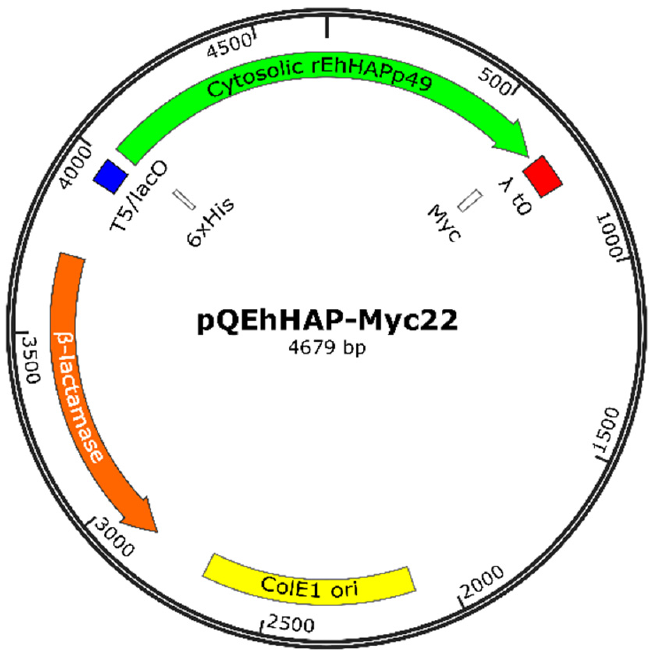
Figure 8. Schematic representation of the pQEhHAP-Myc22 plasmid, which encodes Eh HAPp49 as a 6xHis/Myc-tagged cytosolic protein. ColE1 ori (yellow) functions as the autonomous replication sequence, and the encoded β -lactamase (orange) as a selection marker (Amp R ). As a transcriptional unit, the promoter and terminator: T5/lacO (blue) and λ t0 (red), regulate the gene expression of r Eh HAPp49 through an IPTG-inducible system.